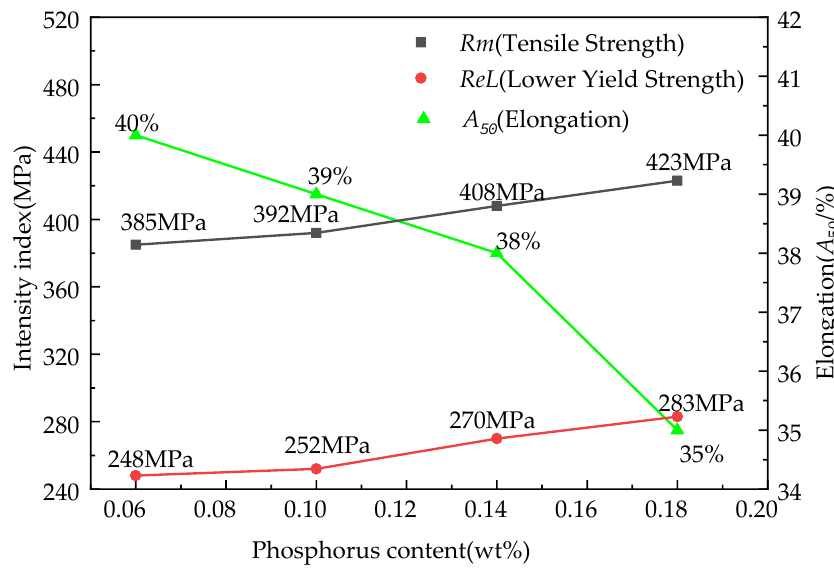
Figure 10. Effect of the target P content on the strength and elongation of the samples.